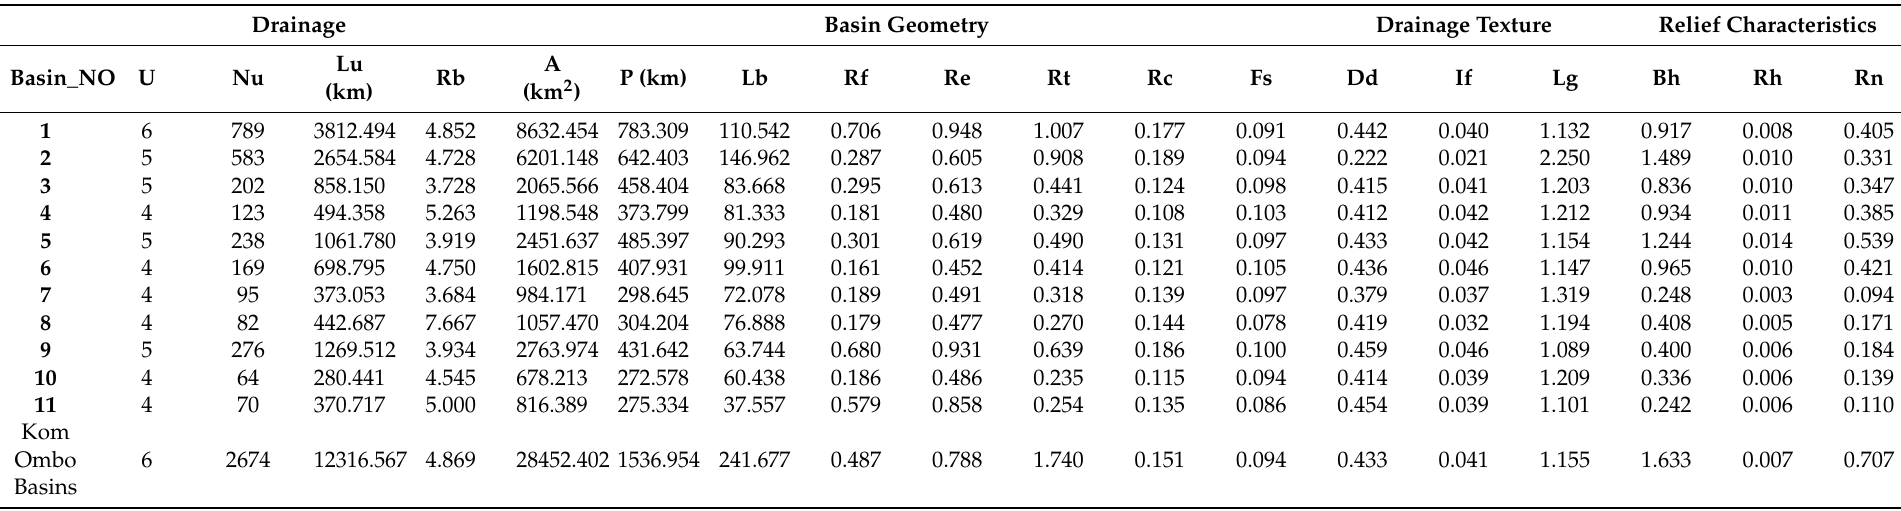
Table 2. Morphometric parameters of the study area.